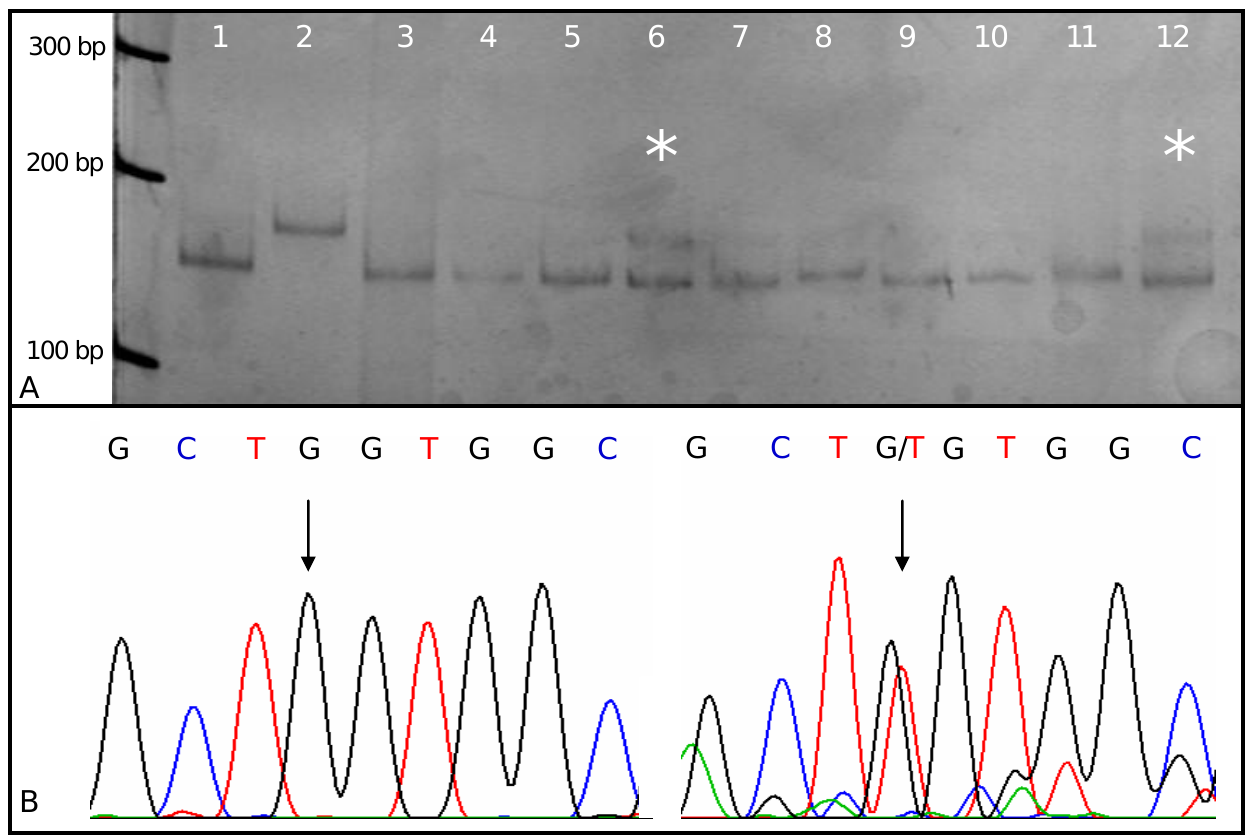
Figure 2. (A) PCR-RFLP analysis of the K-Ras codon 12 mutation. Lane 1: wild-type control; lane 2: mutation control - codon 12 GGT→GAT; lanes 3–12: human tissue samples No. 44, 64, 6, 18, 13, 43, 1, 4, 69, and 29. Lanes 6 (sample No. 18) and 12 (sample No. 29) exhibit aberrant band motilities (*). (B) Sequencing profiles of DNA fragments isolated from polyacrylamide gel. On the left side: wild-type sequence at codon 12. On the right side: shifted band sequence of sample No. 18. Arrows show the transversion of wild-type guanine (on the left side) to thymine (on the right side) at the first base position of codon